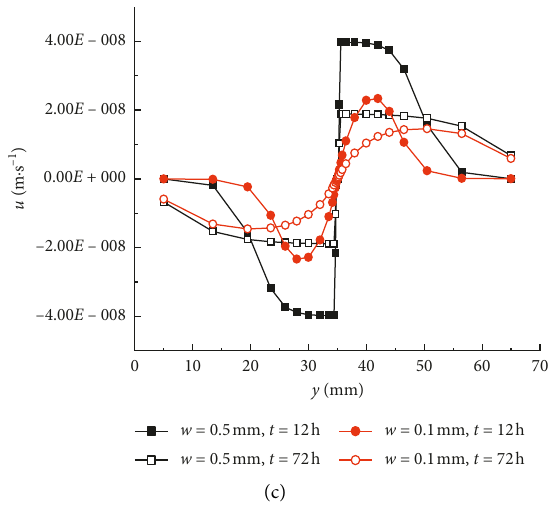
Figure 13: Simulated flow velocity under different working conditions and under (a) different water pressures, (b) different initial saturations, and (c) different crack